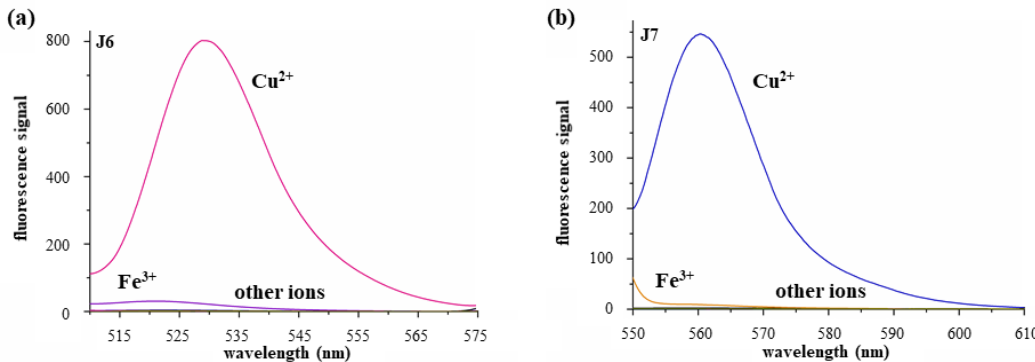
Figure 2. Fluorescence intensity changes of ( a ) J6 and ( b ) J7 upon the addition of various metal ions.